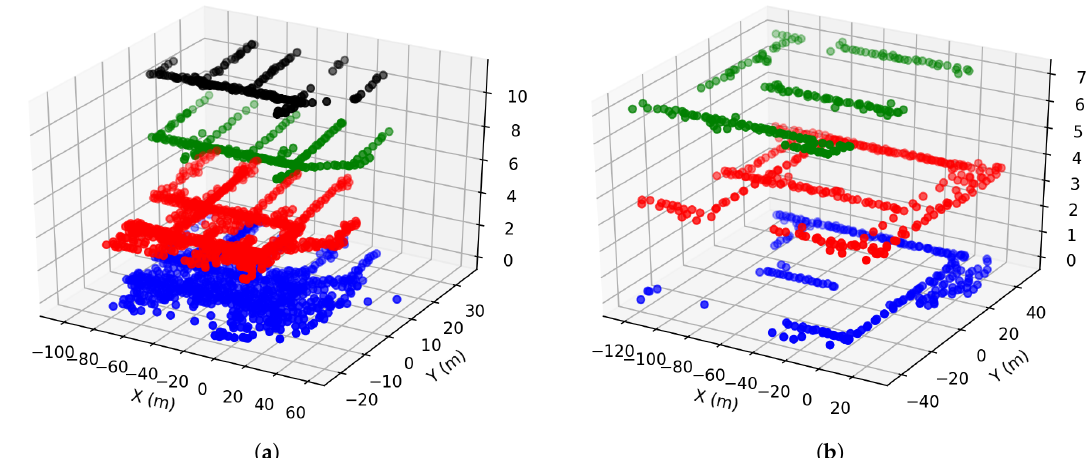
Figure 5. The dataset adopted in our experiment. Different floors are shown in different colors